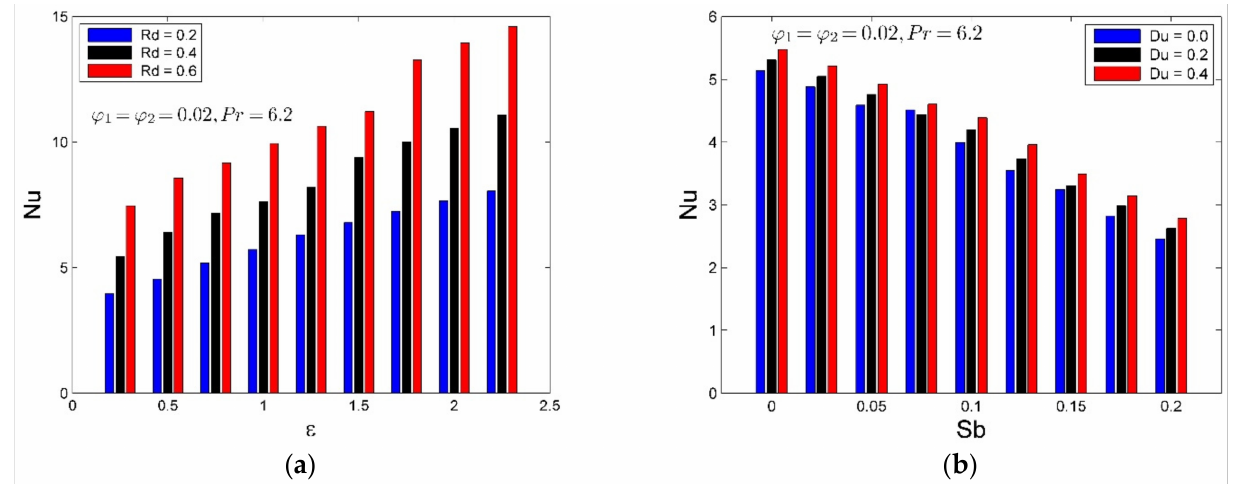
Figure 9. Influences of Rd and Du on Nu .